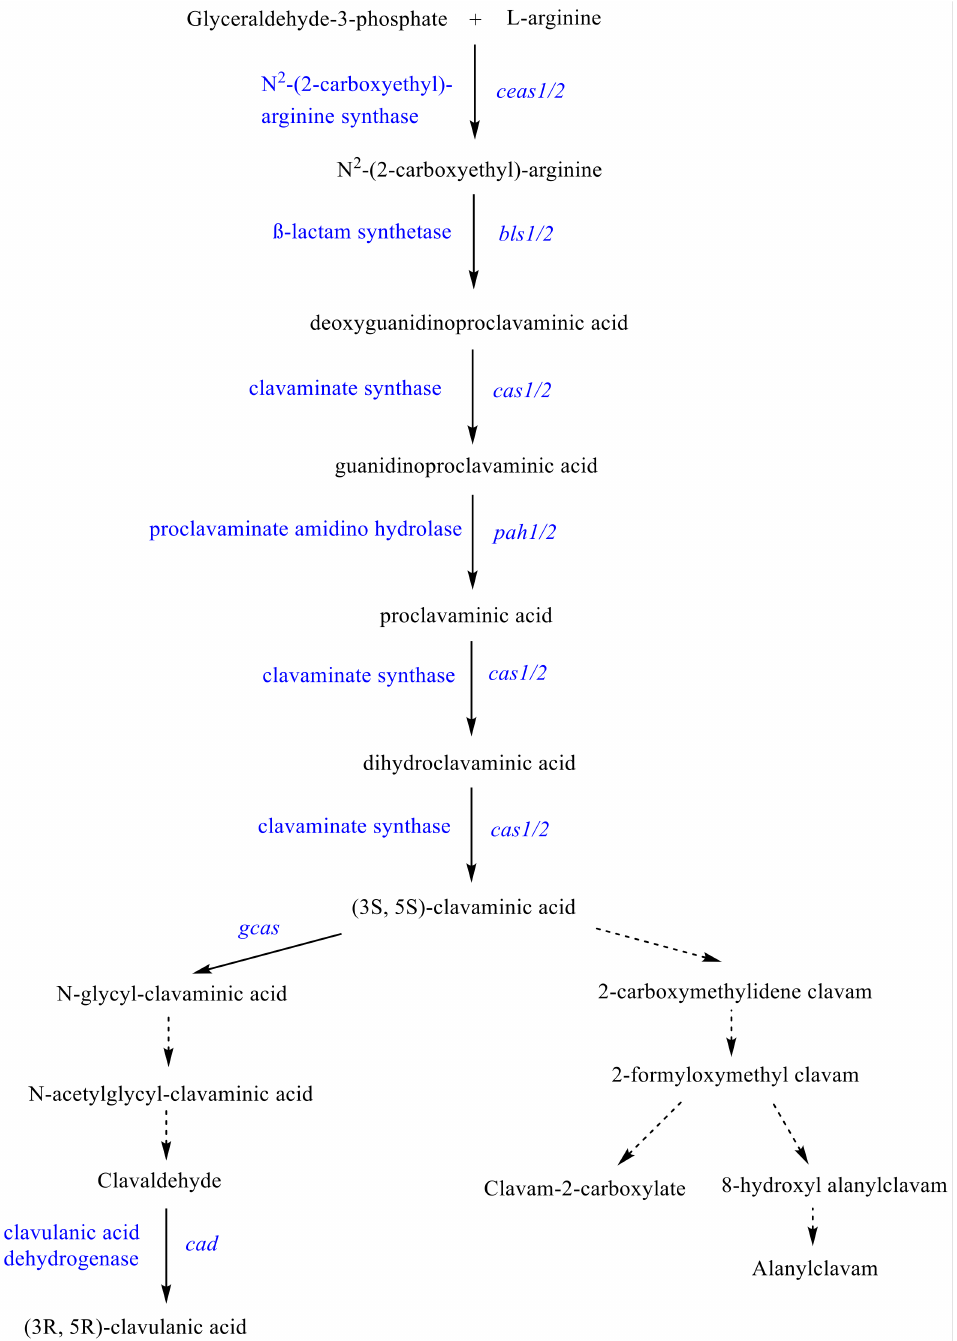
Figure 1. Schematic pathway of clavam biosynthetic pathway in S. clavuligerus . In addition, a metabolic relationship between the tricarboxylic acid (TCA) cycle inter- mediates and antibiotic production has been observed in Streptomycetes sp. [19]. This rela- tionship has been experimentally validated for the case of CA biosynthesis in S. clavuligerus cultivated in fed-batch and continuous modes [20,21]. Some experimental studies sug- gest that CA production is favored during fed-batch operation under phosphate limita- tion [22,23]. The differences in CA titers observed in fed-batch cultivations with defined media, along with the identification of the role of TCA cycle intermediates on the synthesis of CA in S. clavuligerus might help to identify metabolic targets susceptible to genetic modification for rational strain